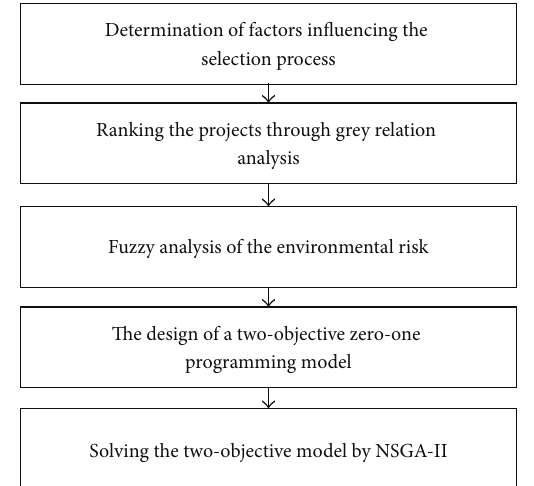
Figure7:Projectselectionbythehybridalgorithmofgreyrelational analysis and nondominated sorting genetic algorithm-II.